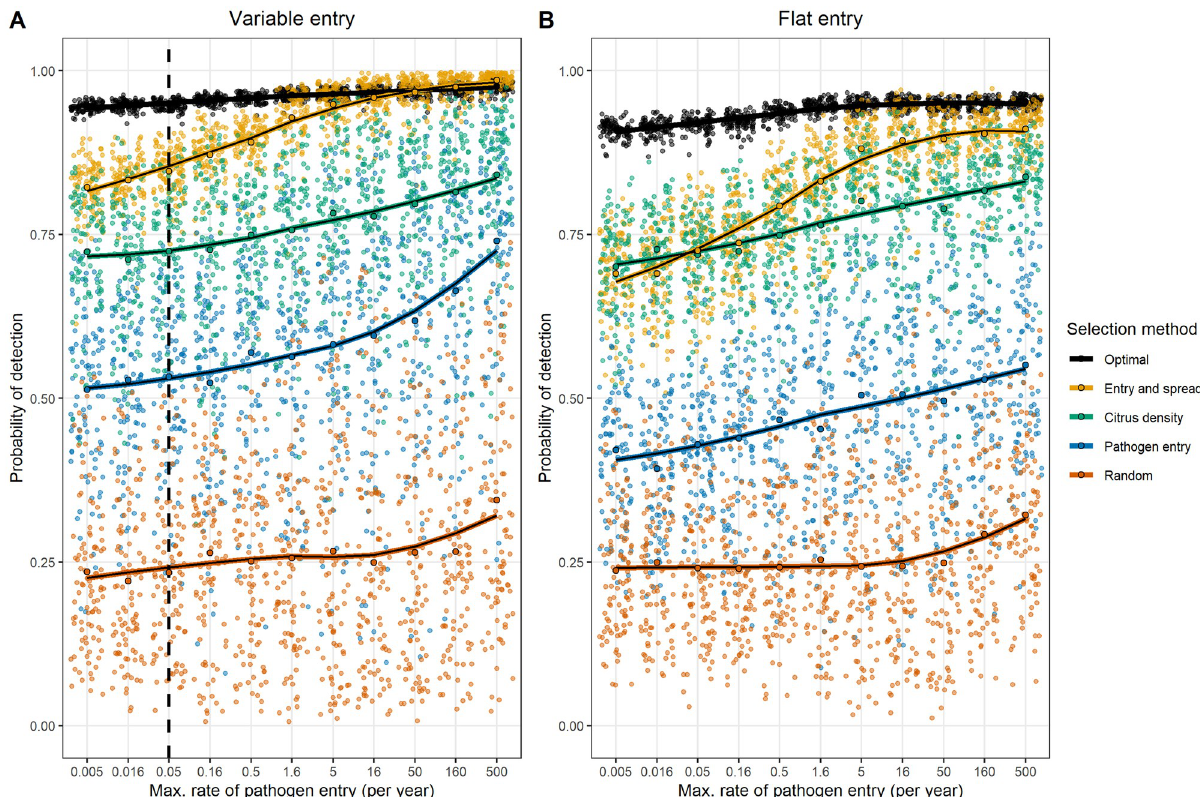
Fig 6. Impact of incorrect assumptions on performance of different site-selection methods. These plots show the mean detection probability under different site-selection methods for different rates and patterns of pathogen entry. Plot A shows the detection probability when pathogen entry follows the travel census model, and plot B shows the same when entry is only affected by the citrus density. In all cases, sites were selected under the baseline model assumptions (that is, a maximal rate of pathogen entry equal to 0.05/year and a distribution of entry based upon the travel census model, as shown in the vertical dashed line). Each selection method was repeated 100 times, with each individual detection probability shown as a coloured point. The mean detection probability is shown as a black-bordered point, and a locally weighted regression curve is overlaid to better illustrate the trends. The risk metrics used for conventional targeted selection represent the product of travel census probabilities and citrus density (‘Entry and spread’), citrus density, the probability of entry according to the travel census model (‘Pathogen entry’), and random selection from the landscape. The data used to create these plots can be found at https://doi.org/10.17866/rd.salford.12759929.v1 (file